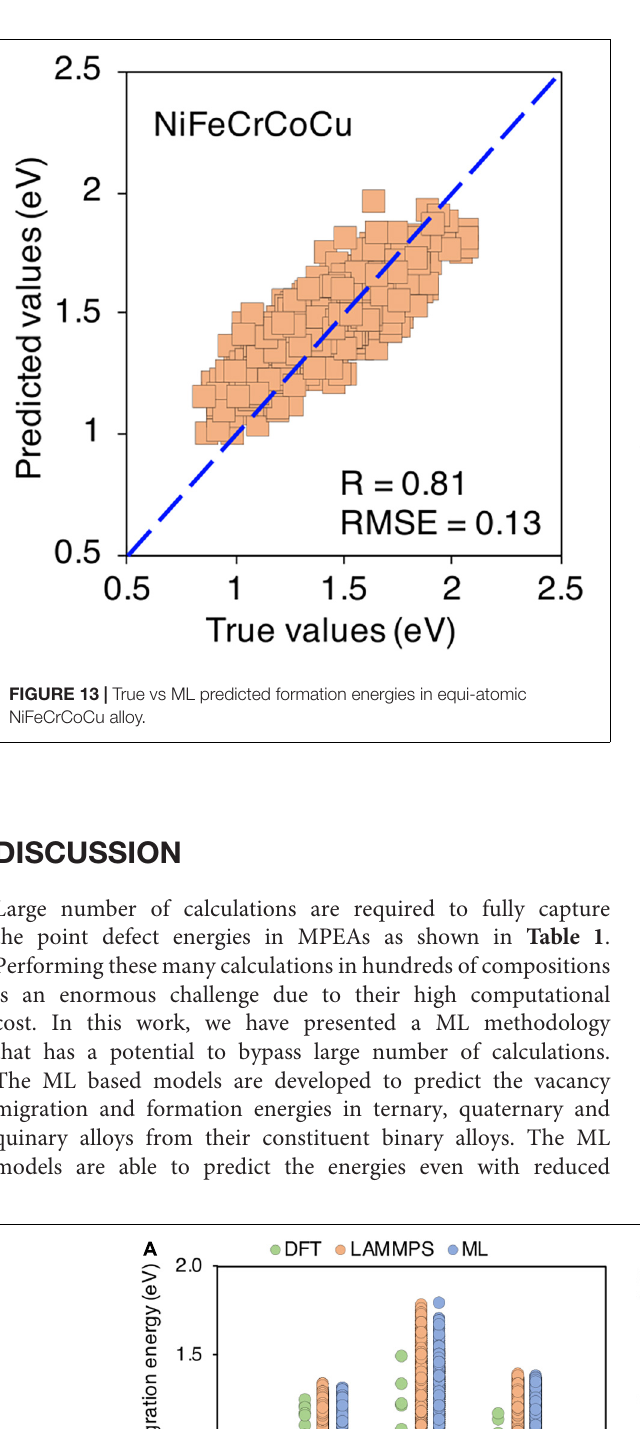
Frontiers in Materials |